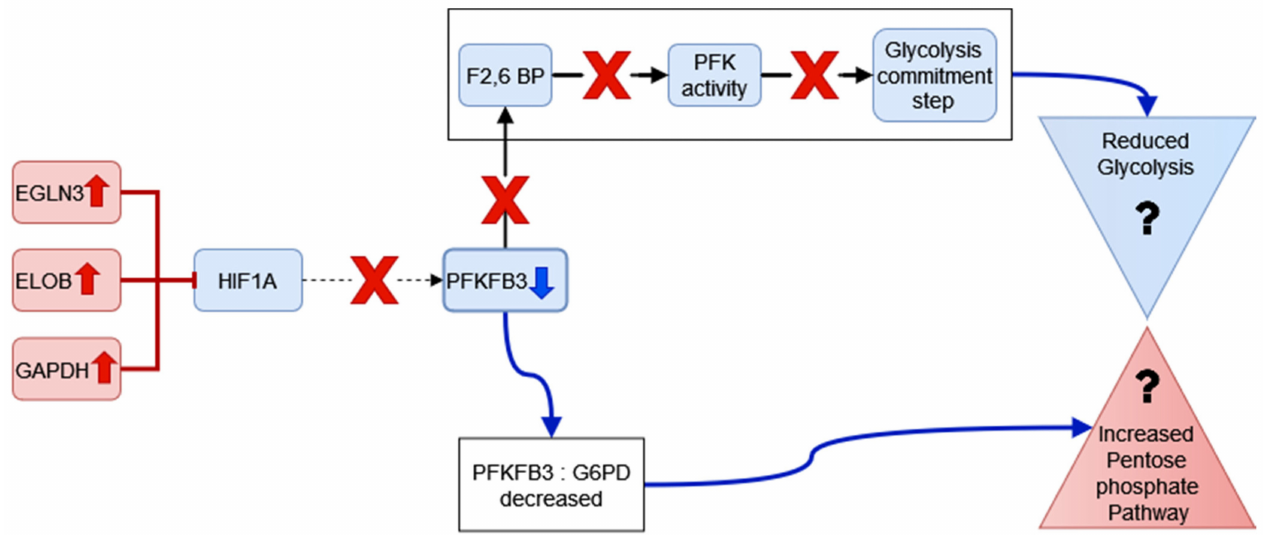
Figure 17. Proposed model for the regulation of glycolysis and pentose phosphate pathway in RA CD8 + Tem cells. EGLN3 , ELOB and GAPDH are upregulated as indicated by the red up arrows. This leads to the inhibition of HIF1A (red T—shaped connector). HIF1A-mediated upregulation of PFKFB3 (black dotted arrow) is blocked (red X) leading to the downregulation of PFKFB3 (blue down arrow). The PFKFB3 catalysed increase in fructose 2, 6 bisphosphate (F 2,6 BP) is abolished, so F 2,6 BP-mediated allosteric activation of phosphofructokinase (PFK) is lost, and the commitment step of glycolysis does not occur. This leads to reduced glycolysis. PFKFB3 downregulation causes a reduction in the ratio of PFKFB3 with G6PD (glucose 6 phosphate dehydrogenase) leading to increased pentose phosphate pathway